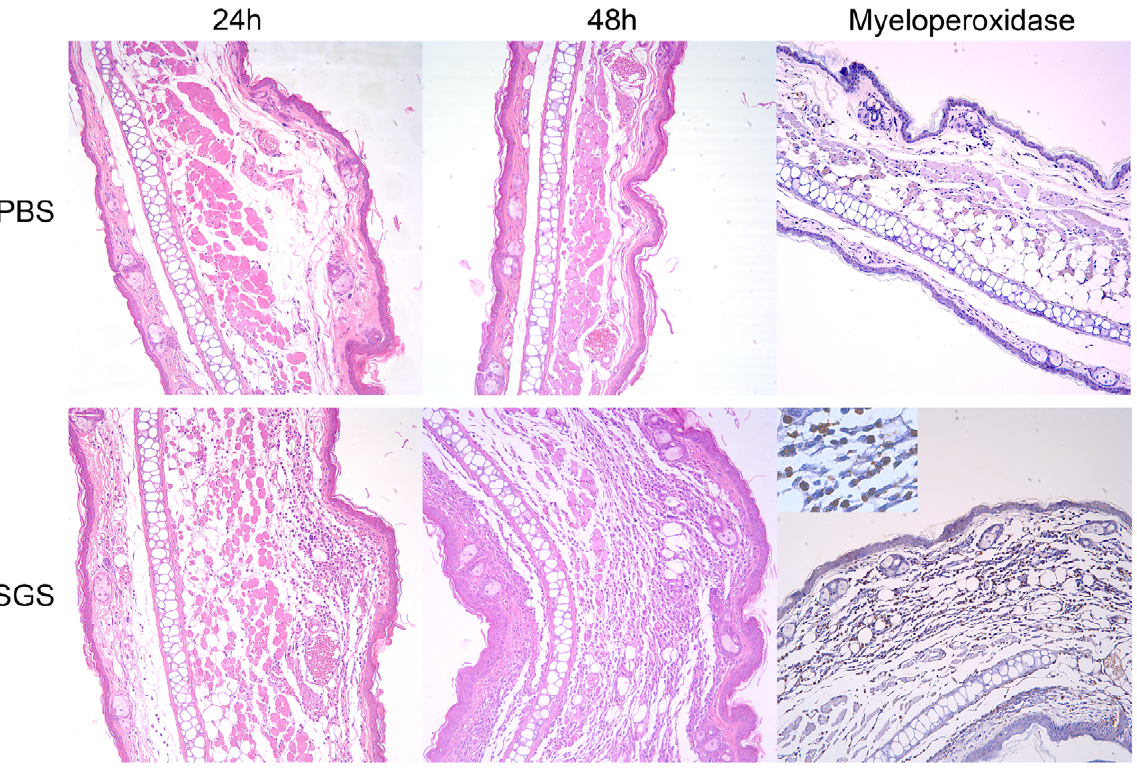
Figure 3. Modulation in leukocyte recruitment and gene expression in mice pre-exposed to L.intermedia saliva. BALB/c mice (five to six per group) received three inoculations with endotoxin-free PBS or L. intermedia SGS. Fifteen days after the last immunization, air pouches were raised and inoculated with L. intermedia SGS. Exudates and air pouch lining tissue were collected twelve hours later. Leukocytes were enumerated microscopically. (A) Total number of recruited leukocyte and (B) total number of neutrophils, monocytes, eosinophils, and lymphocytes accumulated in air pouches. Relative expression of chemokines (C) and cytokines (D) in the air pouch lining tissue was determined by real-time PCR. The data shown are from a single experiment representative of two independent experiments. (* P , 0.05; ** P , 0.01).